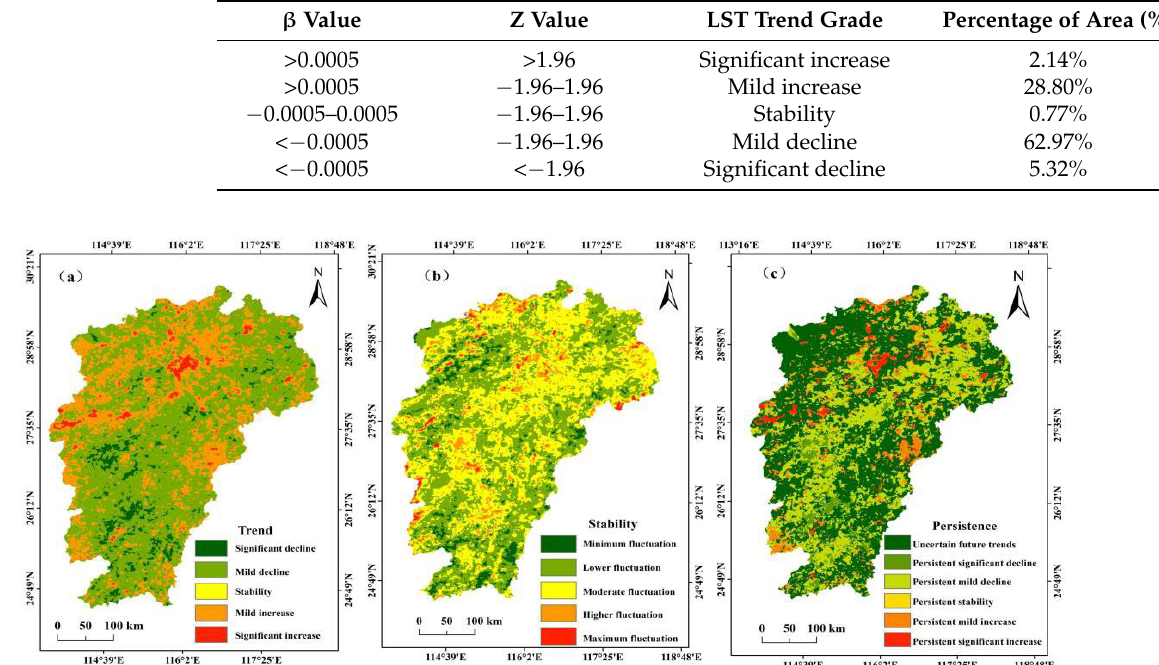
Table 3. Classification of LST coefficient of variation.